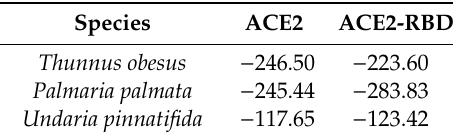
Table 3. Energy scores for the molecular docking top solutions. The ACE2 cleft appears to be a hot region, hosting the peptide in 5 out of 6